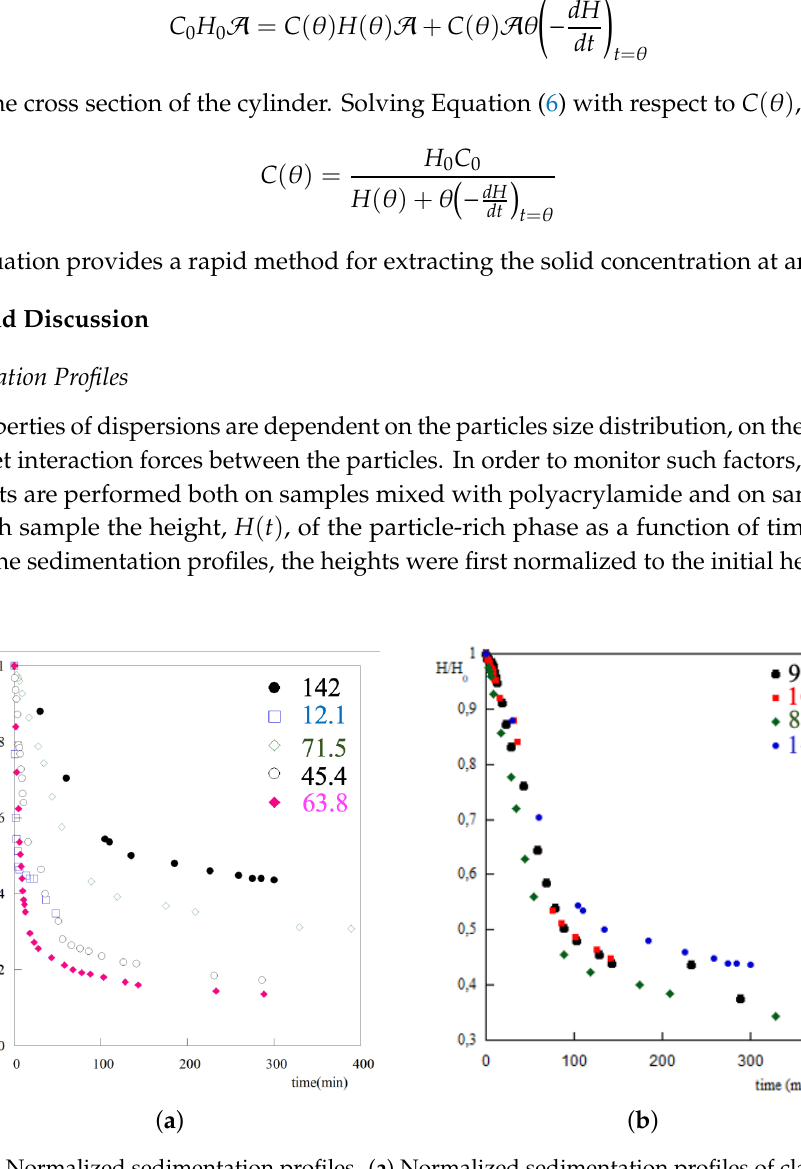
Figure 3. Normalized sedimentation profiles. ( a ) Normalized sedimentation profiles of clay material polymer free. Dispersions from Occhito reservoir at different solids concentration (kgm − 3 ), indicated by numbers in the plot. ( b ) Normalized sedimentation profiles of dispersion mixed with polyacrylamide. Material from Occhito reservoir at different solids concentration, indicated by numbers in the plot.